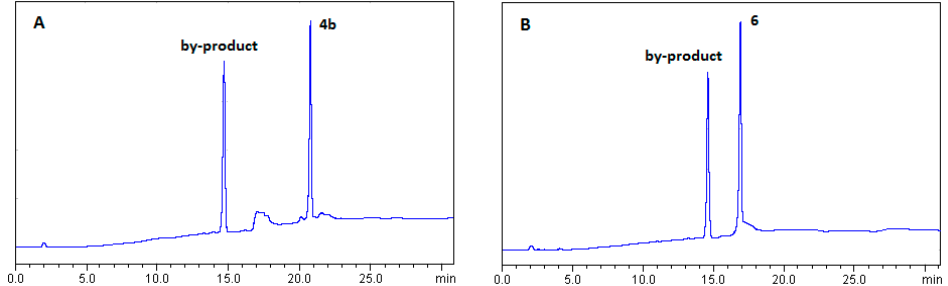
Figure 3. HPLC analysis of ( A ) the reaction mixture product between bis(2-aminophenyl) disulfide and palmitoyl chloride in presence of NEt 3 ; ( B ) the reaction mixture after reduction with NaBH 4 and acidification with AcOH; Column: LiChrospher ® 100 RP-18 (5 µm) LiChroCART ® 250-4; Mobile phase: THF/H 2 O; Gradient: 50% THF to 100% THF in 30 min; Flow rate: 1mL/min; Detection at 254 nm.